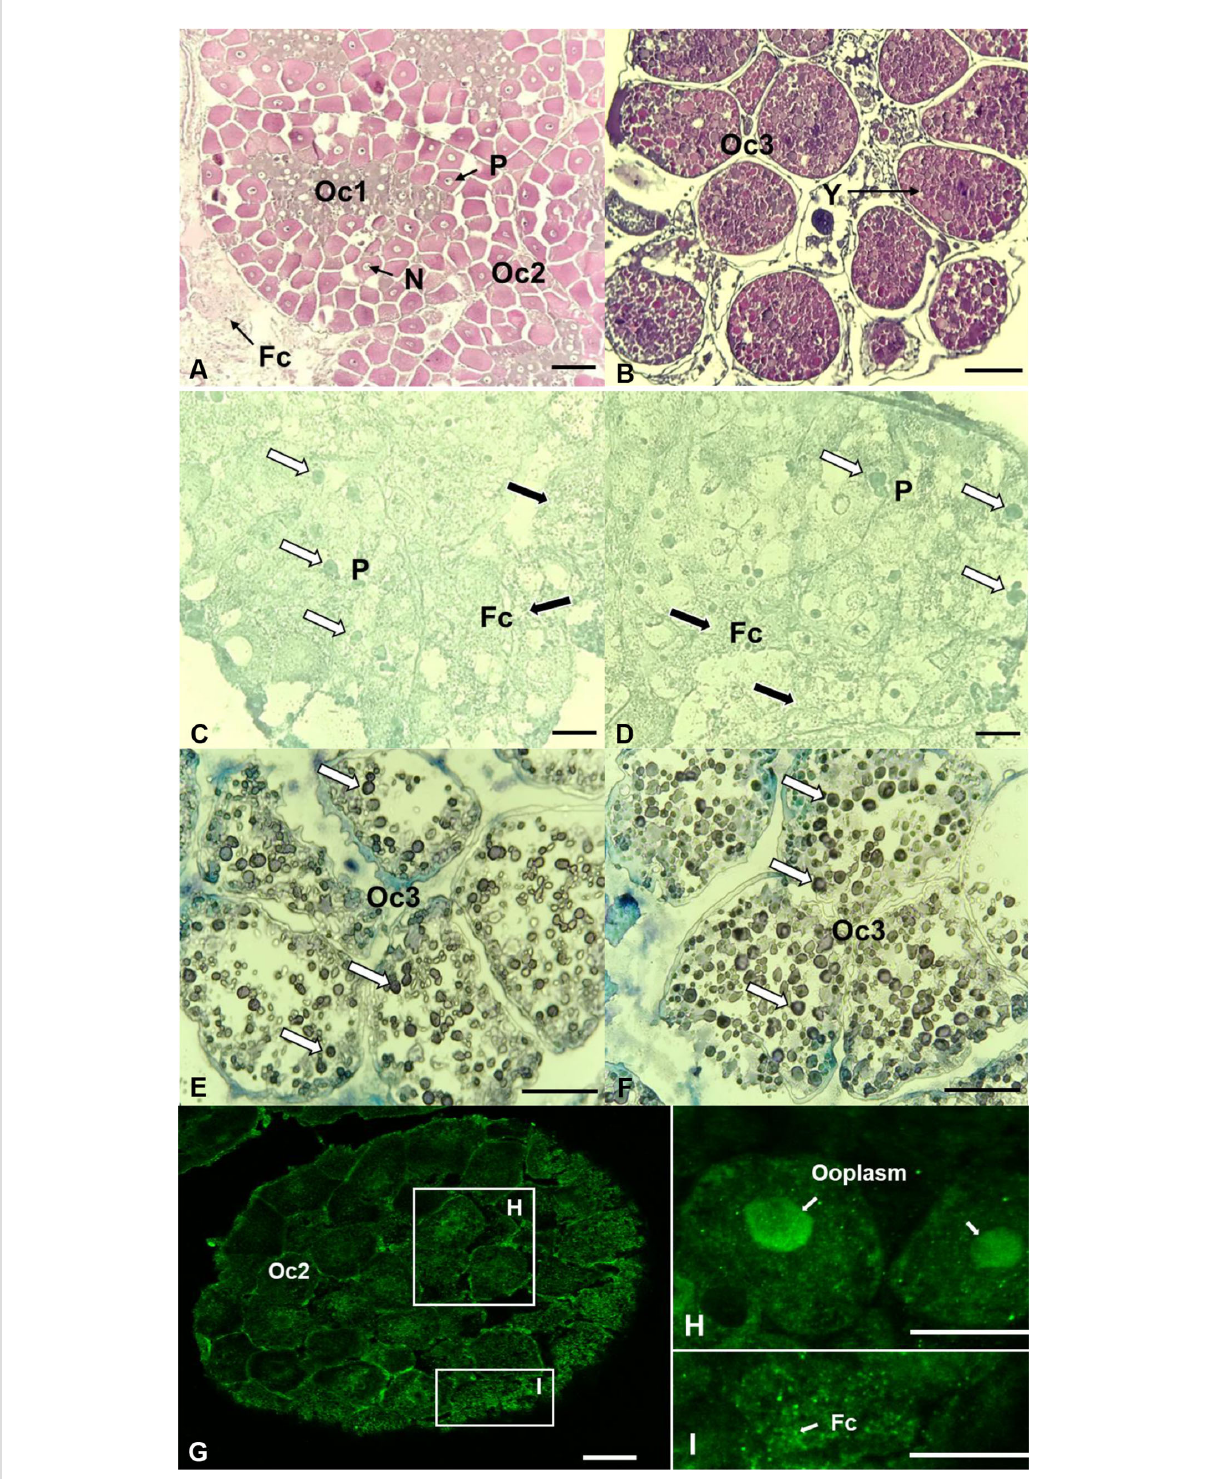
FIGURE 8 Localization of 17 b HSD8 in the ovaries (stage 2 and 3) of adult female C. sapidus using in situ hybridization (mRNA) and immunohistochemistry (protein). H&E staining (A, B) ; ISH: antisense probe hybridization ( C – E : 17 b HSD8a ; D – F : 17 b HSD8b ); Whole-mount immunohistochemistry: 17 b HSD8 speci fi c antibody (G – I) . The arrows point to a representative positive signal. Abbreviations: N, nucleus; Y, yolk; P, perinucleus; Fc, follicular cell; Oc1, early primary oocyte; Oc2, late primary oocyte; Oc3, early vitellogenic oocyte. Scale bars = 100 m